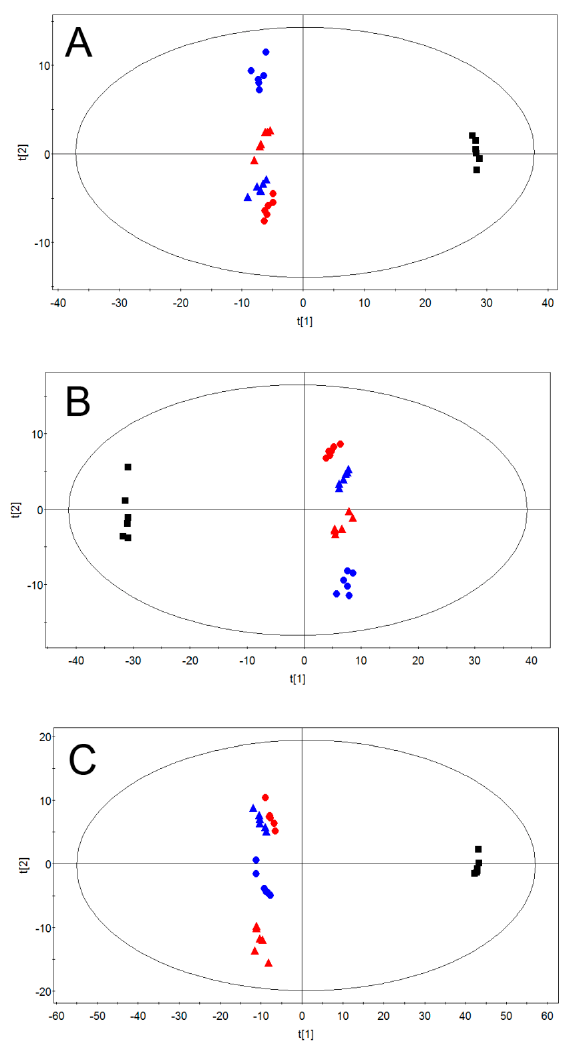
Figure 2. PCA score plots based on QTOF data sets of MCF-7 cells treated with different concentrations of metalaxyl enantiomers. ■ Control, ▲ S -metalaxyl (10 µM), ▲ S -metalaxyl (50 µM), ● R -metalaxyl (10 µM), ● R -metalaxyl (50 µM). ( A ) Positive mode, ( R 2 X = 0.656, Q 2 = 0.552); ( B ) negative mode, ( R 2 X = 0.715, Q 2 = 0.629); ( C ) negative + positive mode, ( R 2 X = 0.783, Q 2 = 0.685).